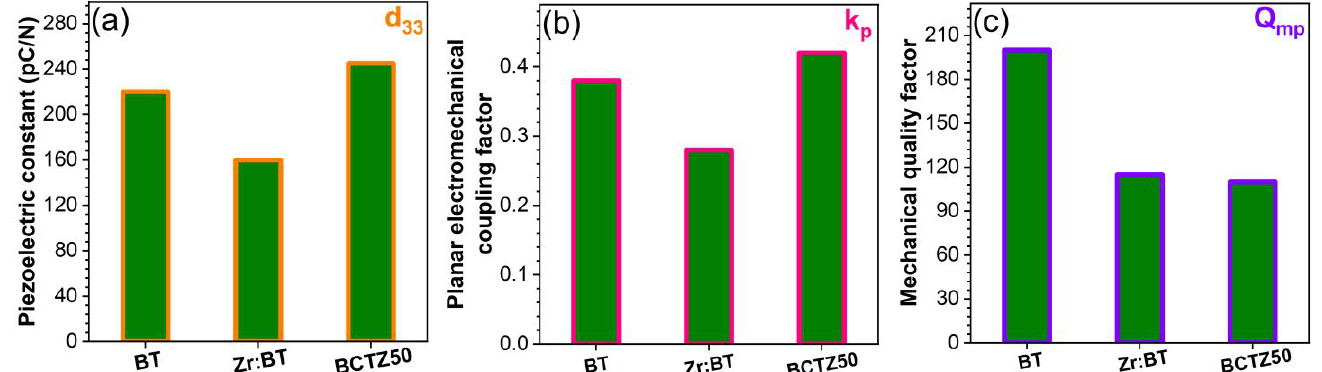
Figure 6. ( a ) Longitudinal piezoelectric constant d 33 ; ( b ) planar coupling factor k p ; and ( c ) mechanical